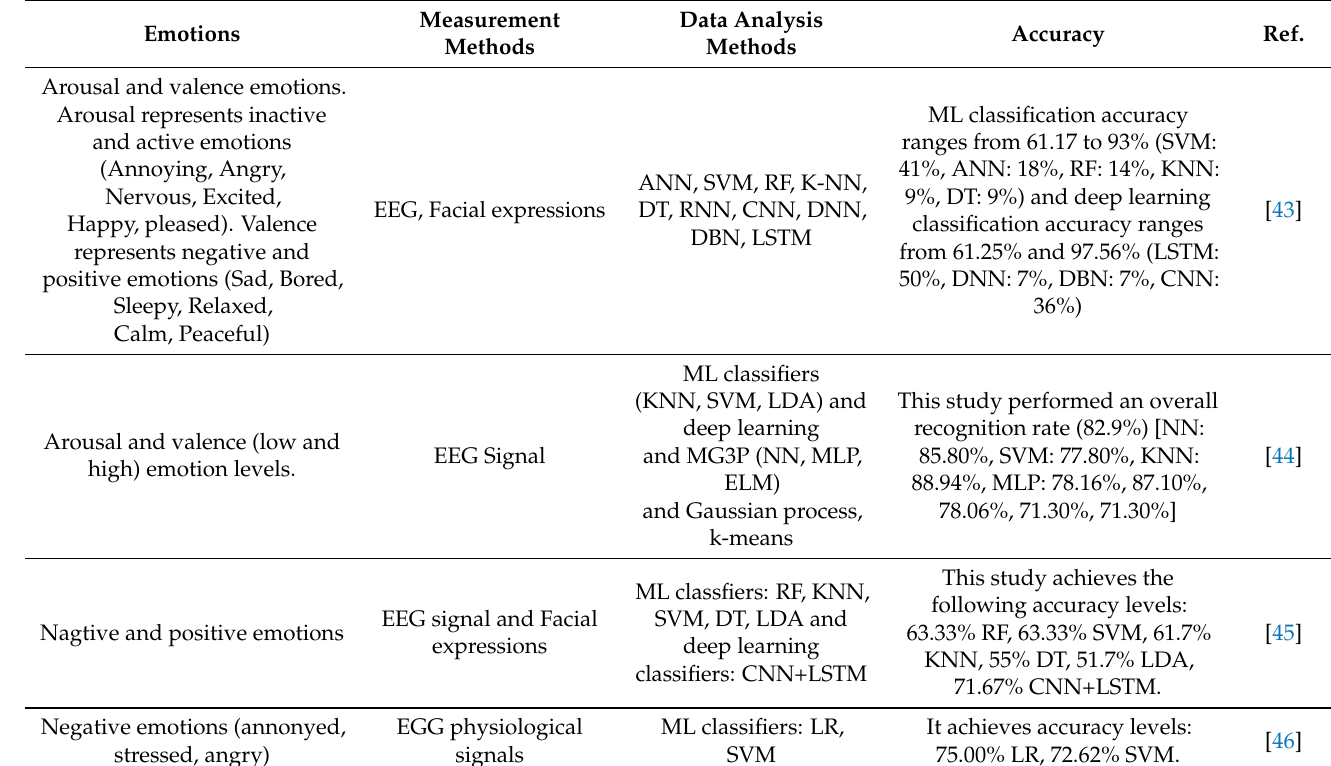
Table 3. Recent Previous Research on Recognizing Emotion from Physiological Signals and Facial Expressions (2021 and